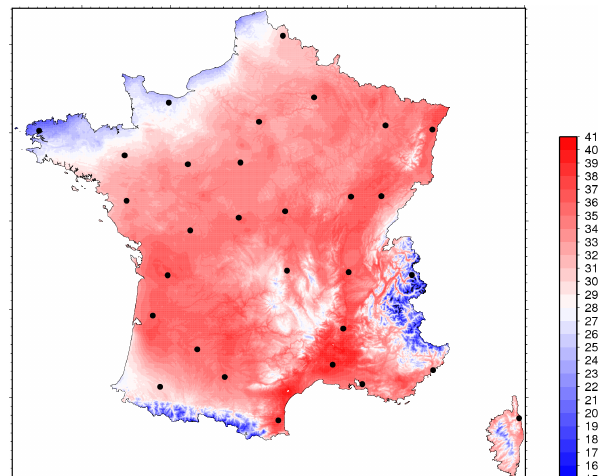
Figure 3. Spatialization of maximum temperature 4 August 2018 over France from ANASTASIA analysis over France. Black dots correspond to stations used to compute the national thermic